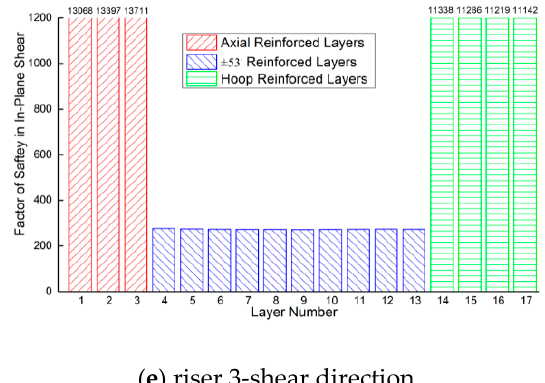
Figure 13. Factor of safety of composite layers for 0.36 m/s in ( a ) riser 2 ‐ fiber direction, ( b ) riser 2 ‐ transverse direction, ( c ) riser 3 ‐ fiber direction, ( d ) riser 3 ‐ transverse direction and ( e ) riser 3 ‐ shear direction.